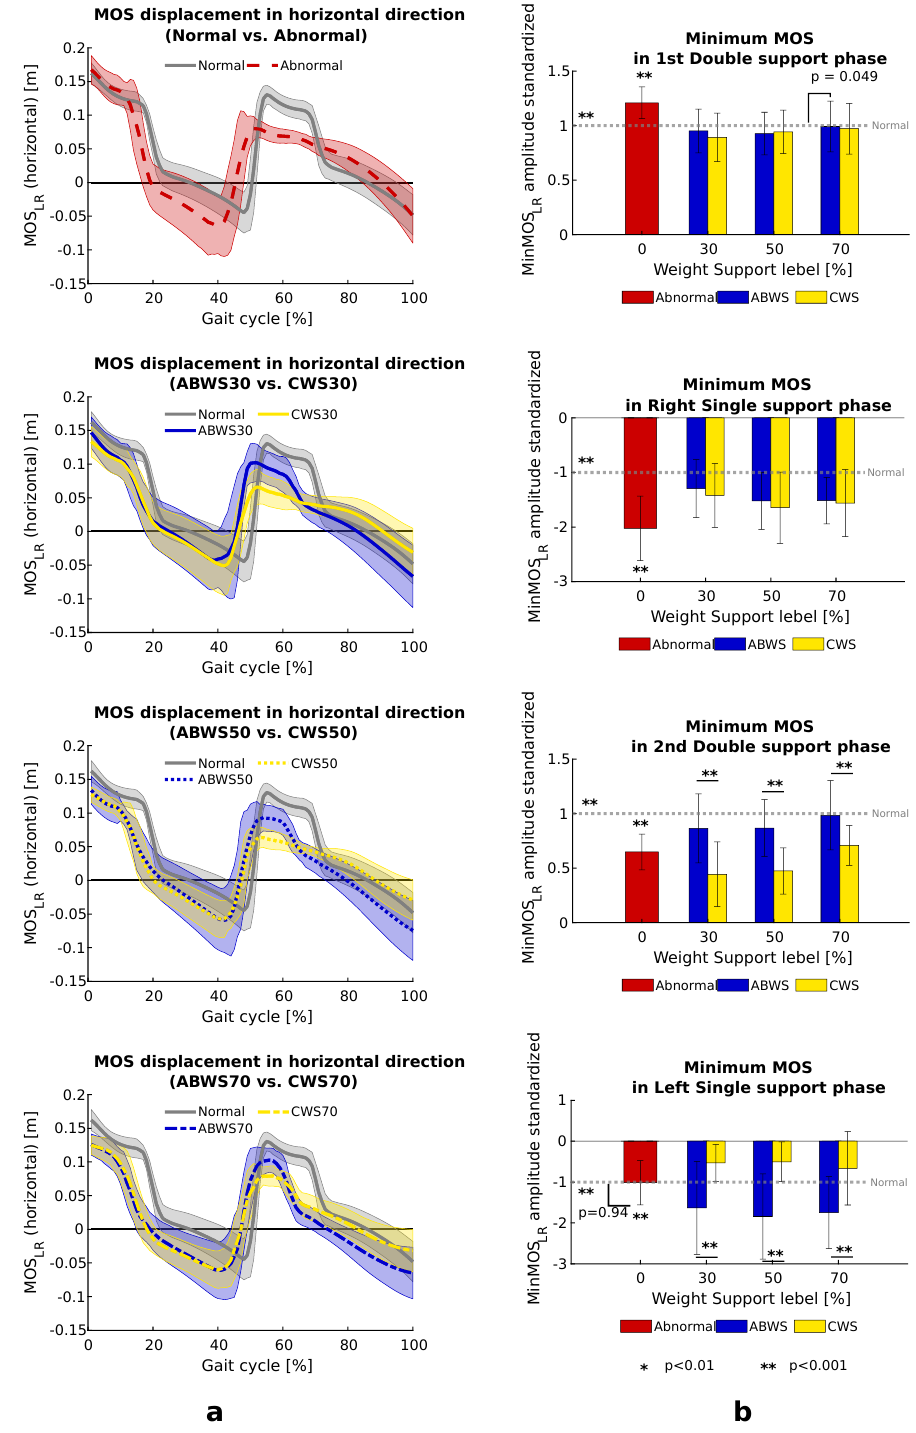
Figure 8. The column ( a ) shows comparisons of the MOS in horizontal direction. The column ( b ) shows comparison of the minimum MOS at single support and double support among all walking conditions. The significant value ( p ) was selected as 0.05. * and ** show that p is less than 0.01, and 0.001,